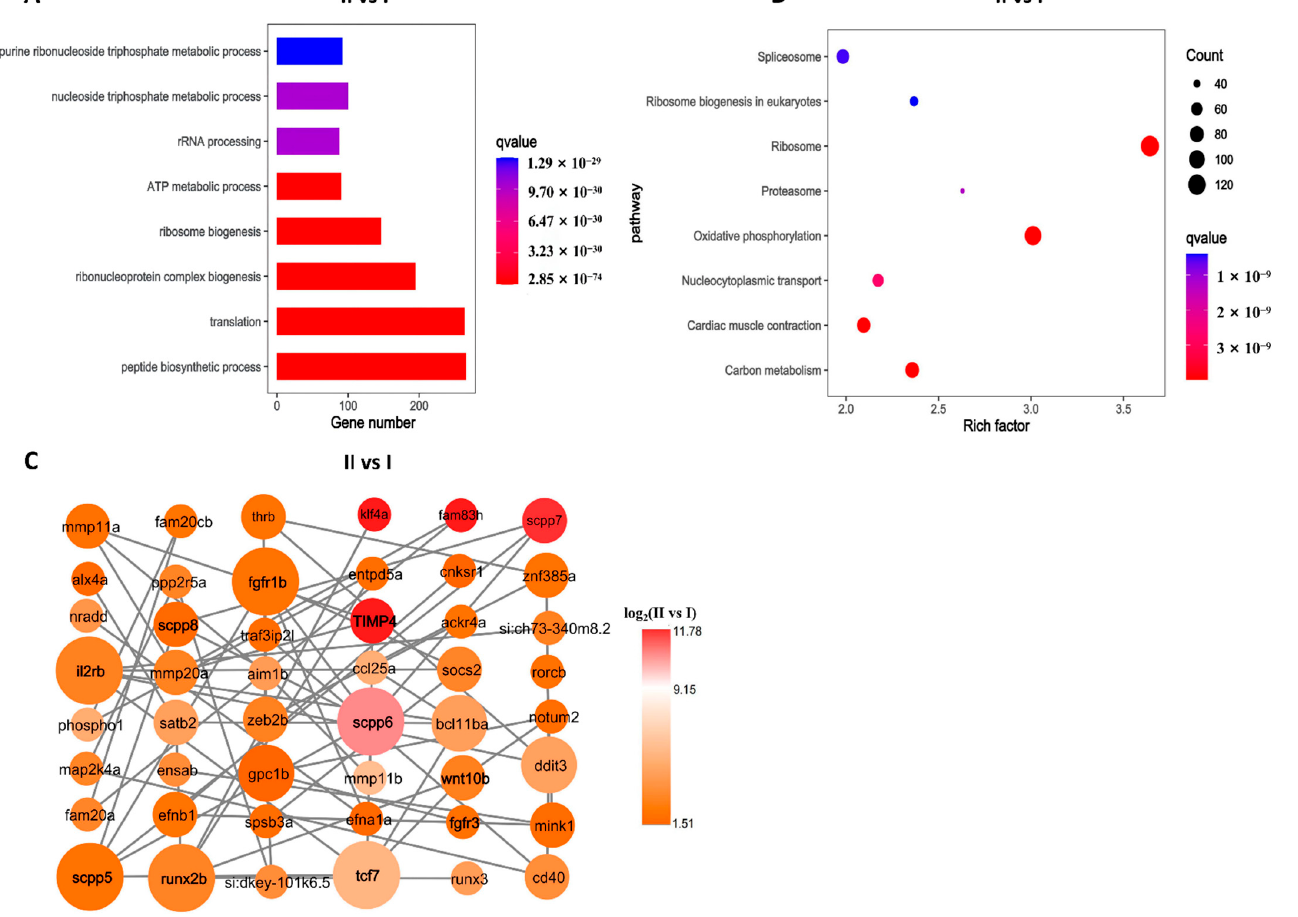
Figure 4. KEGG and GO analysis of transcriptome data. ( A ) Differential gene ontology (GO) classification of (II vs. I) groups. ( B ) KEGG pathway classification of (II vs. I) groups. ( C ) In the gene interaction network diagram in group (II vs. I), the bubble size represents the number of connection points between the focal gene and other genes; the more connection points, the more important the gene is in the enriched pathway. Changes in color from red to orange represent a decrease of expression.